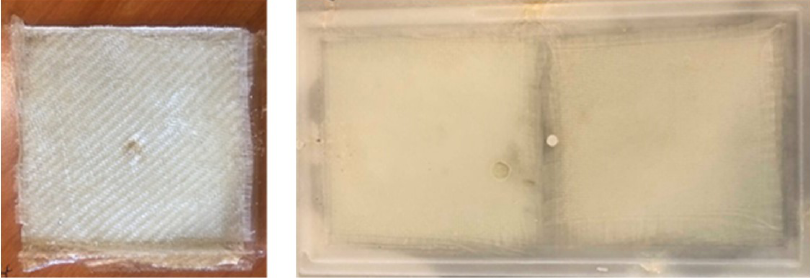
Figure 2. PLLA matrix composites obtained with molds 1 (run 13, left) and 2 (run 15, right), respectively.